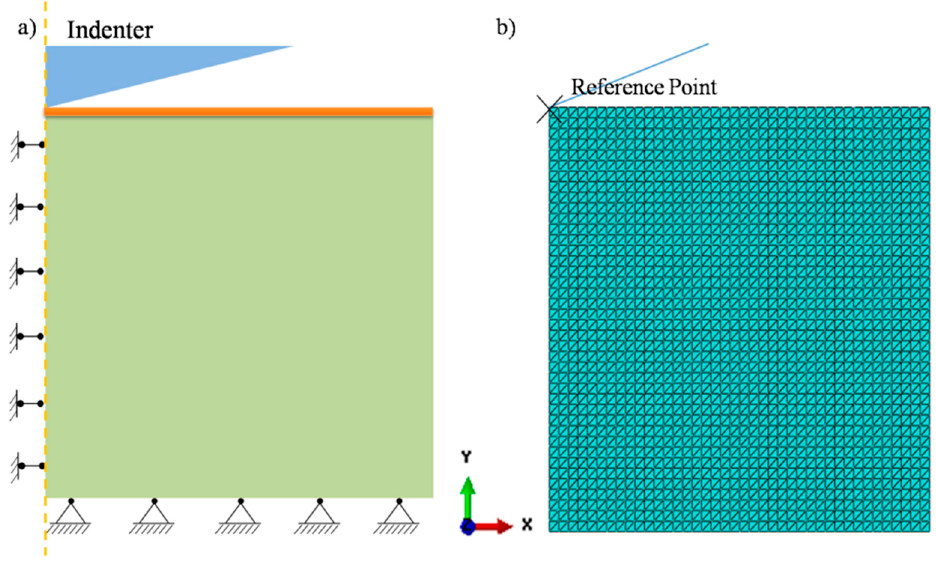
Figure 4. ( a ) The geometric model of film/substrate system; ( b ) the mesh partition of model. A vertical constraint is imposed on the bottom of the model, and an axisymmetric constraint is imposed on the left axis of symmetry. A CAX3 element is selected for the film and substrate materials, and the triangular mesh is used for free division as shown in Figure 4b. Assuming that the indenter is an ideal rigid body and the thin film yield stress H σ ≈ [29,30]. Using a displace- is derived from its relationship with hardness, / 3.2 fy